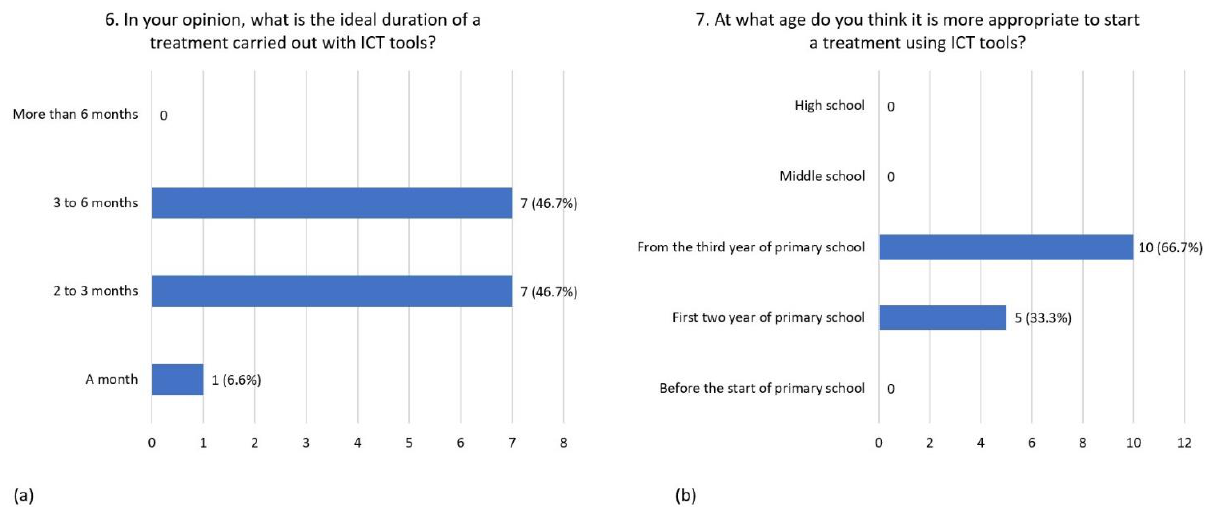
Figure 3. Distribution of responses to question 4 ( a ) and question 5 ( b ).